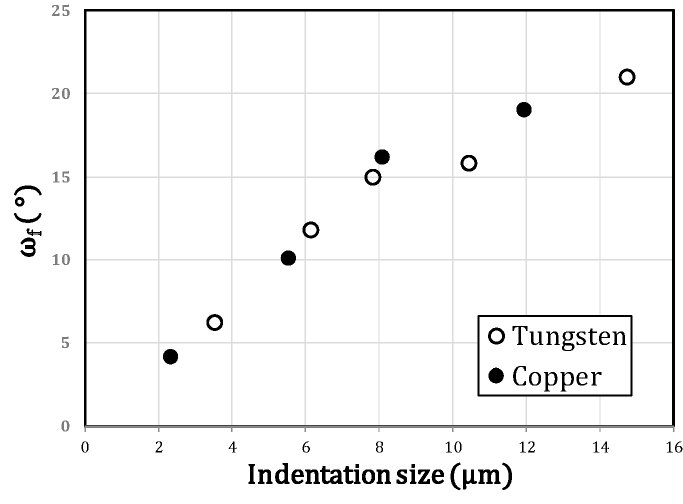
Figure 13. Variation of the maximum misorientation angle ω f versus the indentation size in tungsten and copper. The original data were reported by Kiener et al.